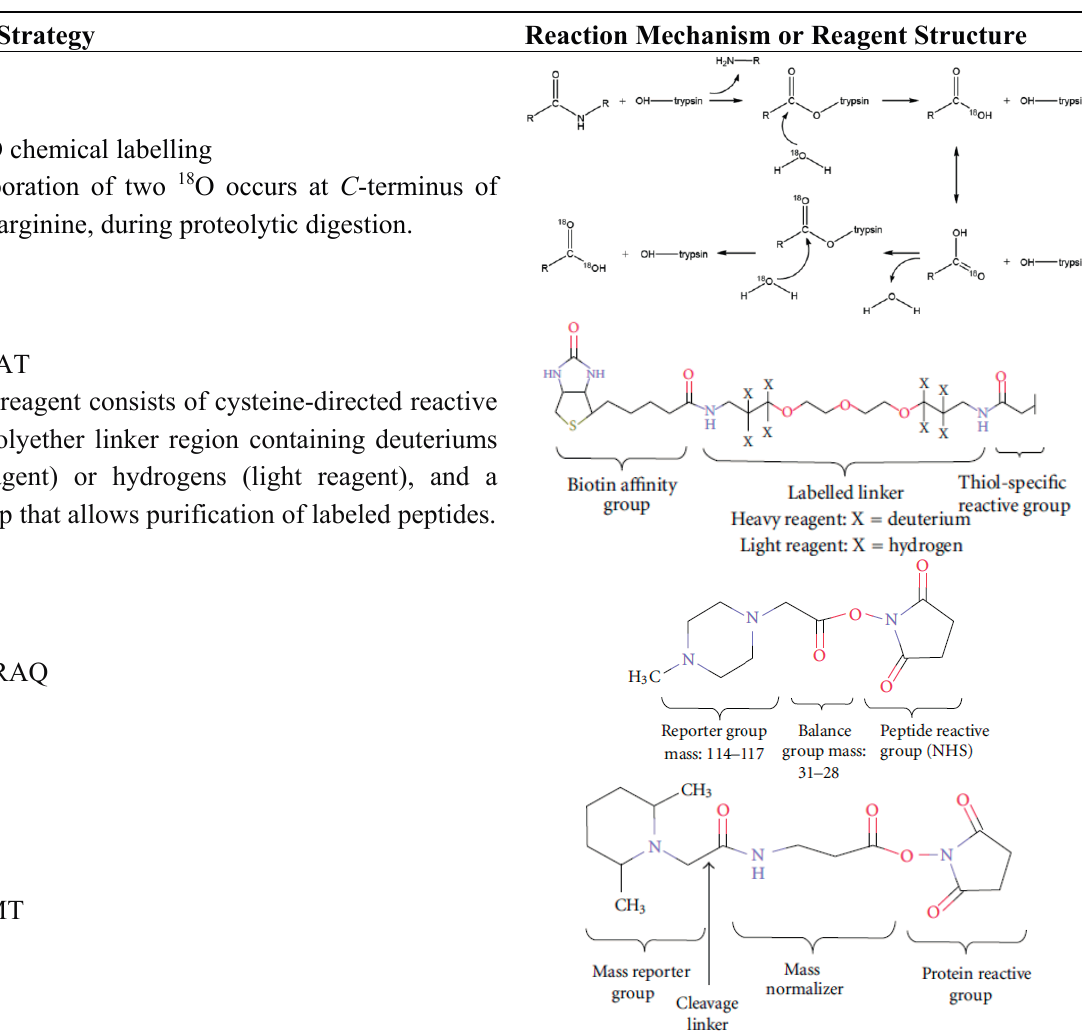
Table 1. The most common isotopic